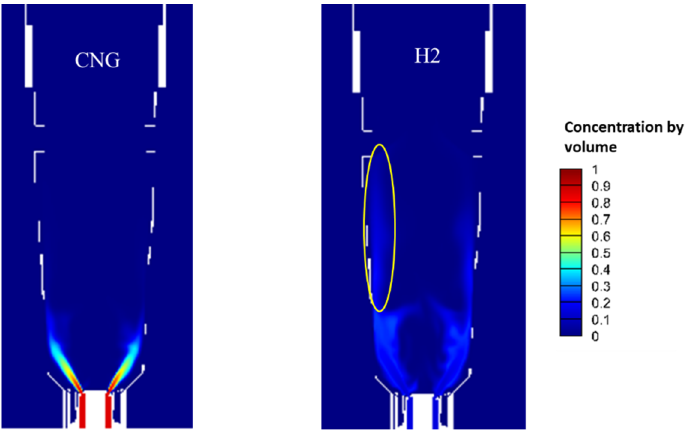
Figure 20. Concentration of NG and H2 in slice 1—base load CNG vs. 15% H2 case.